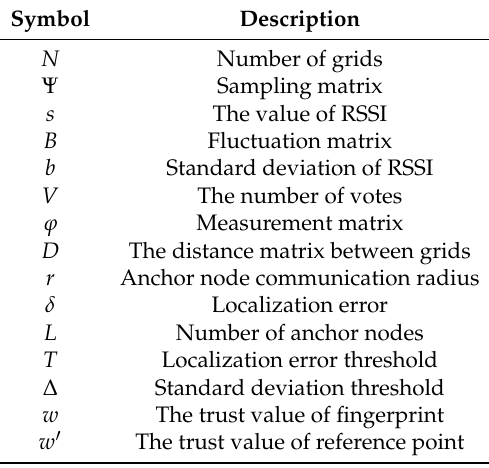
Table 1. The symbols used in this